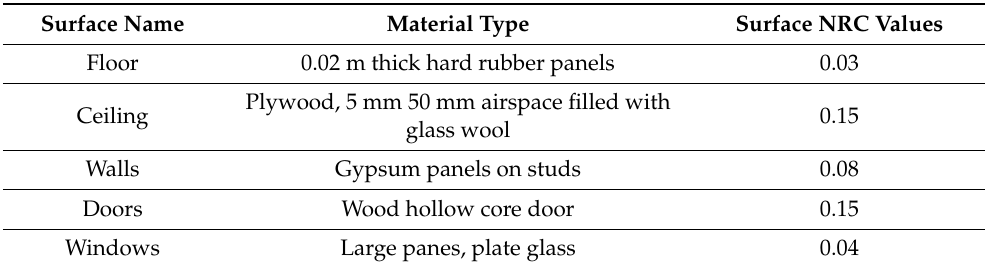
Table 1. Material type noise reduction coefficients (NRCs) defined in the